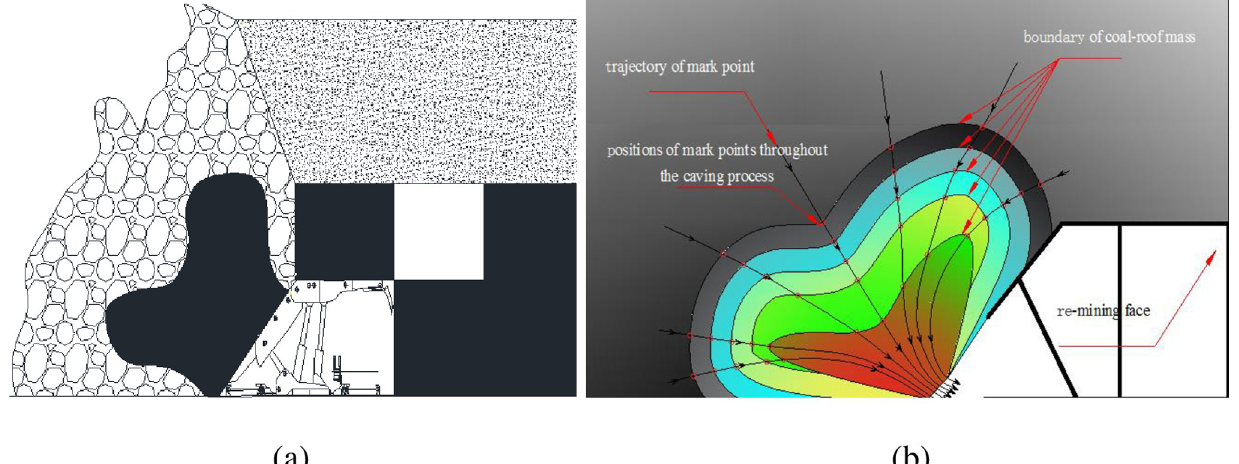
Fig 7. (a) Funnel-shaped geometry of top coal during caving operation; (b) Progressive development of coal-roof boundary.